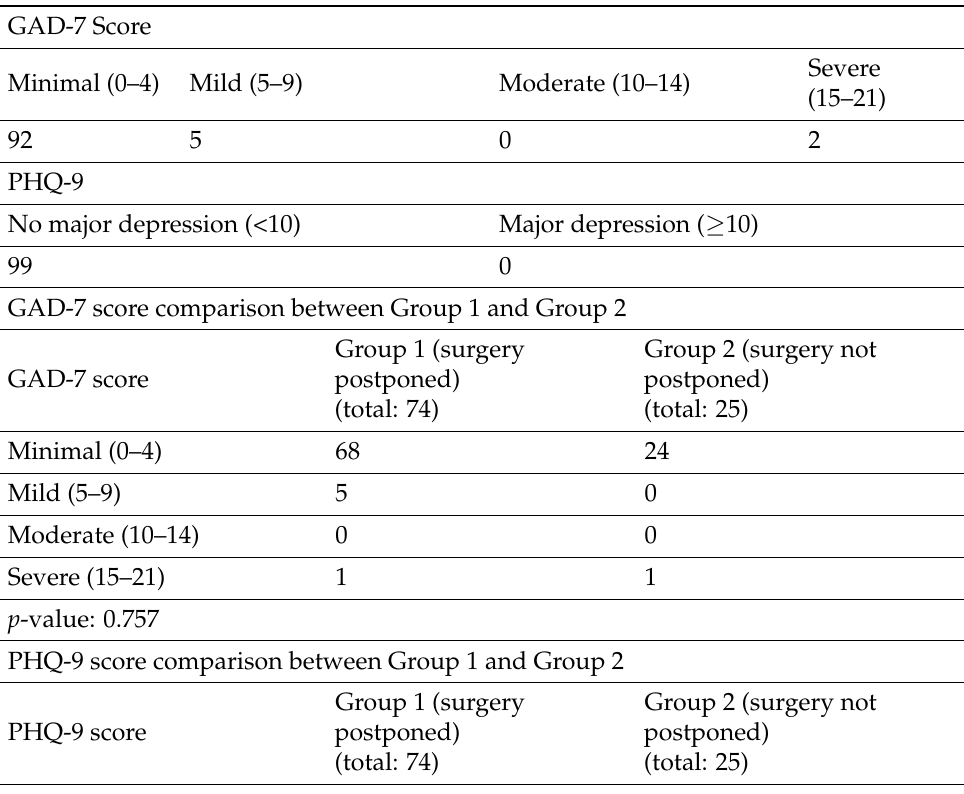
Table 2. Results of GAD-7 and